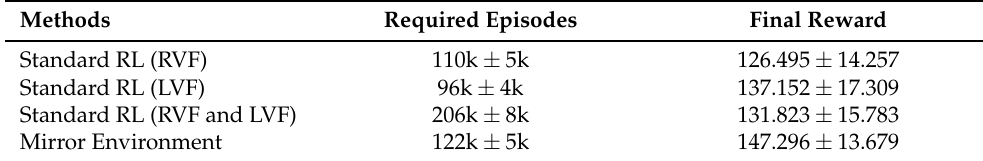
Table 1. Number of required episodes and final